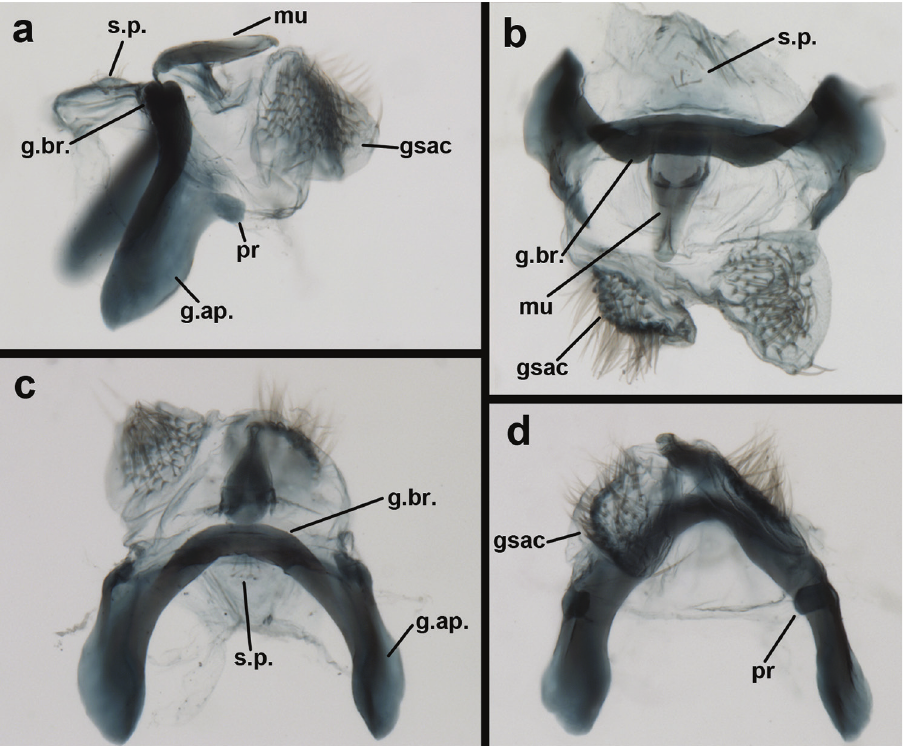
Figure 67. Ungla nigromaculifrons Sosa: Male genitalia, ( a ) gonarcal complex, lateral, with gonosac- cus expanded ( b ) gonarcus, dorsal [Note internal structure of mediuncus.] ( c ) gonarcus, posterior and slightly dorsal [Note shape of gonarcus.] ( d ) gonarcus, frontal. gsac gonosaccus g.ap. gonarcal apodeme g.br. gonarcal bridge mu mediuncus pr unarticulated process on frontal margin of gonarcal apodeme s.p. setose subanal plate (Venezuela, Táchira,